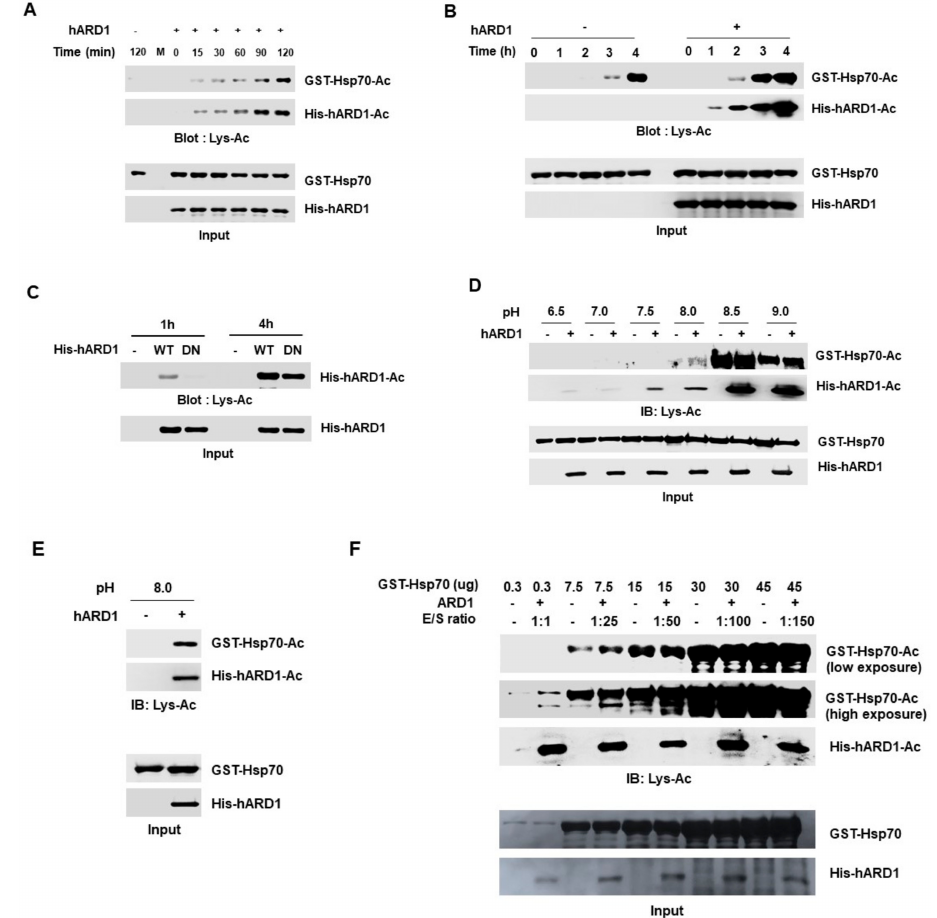
Figure 5. hARD1 / NAA10-mediated lysine acetylation occurs under limited reaction conditions. ( A ) Autoacetylation activity of hARD1 / NAA10 is dependent on the reaction time. A time-dependent in vitro acetylation assay was performed and western blot analysis was carried out to analyze the levels of acetylated protein. ( B ) hARD1 / NAA10-mediated lysine acetylation in vitro is limited to a